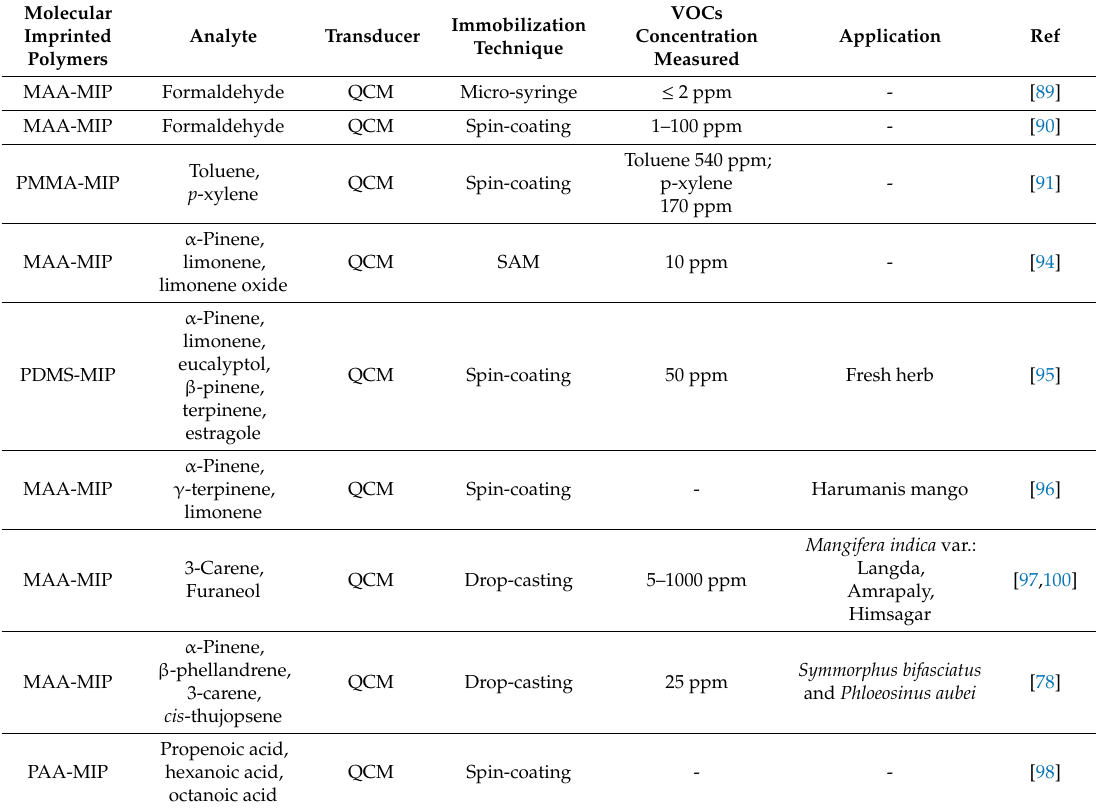
Table 2. Gas sensors equipped with Molecular Imprinted Polymers: main features and strategies. Molecular